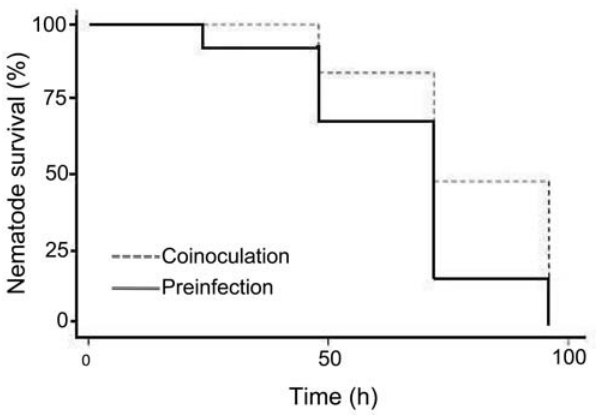
Figure 1. Comparison of inoculation procedures. Comparison of nematode survival between worms co-inoculated with C. albicans during compound exposure, and worms pre-infected with the fungus prior to compound